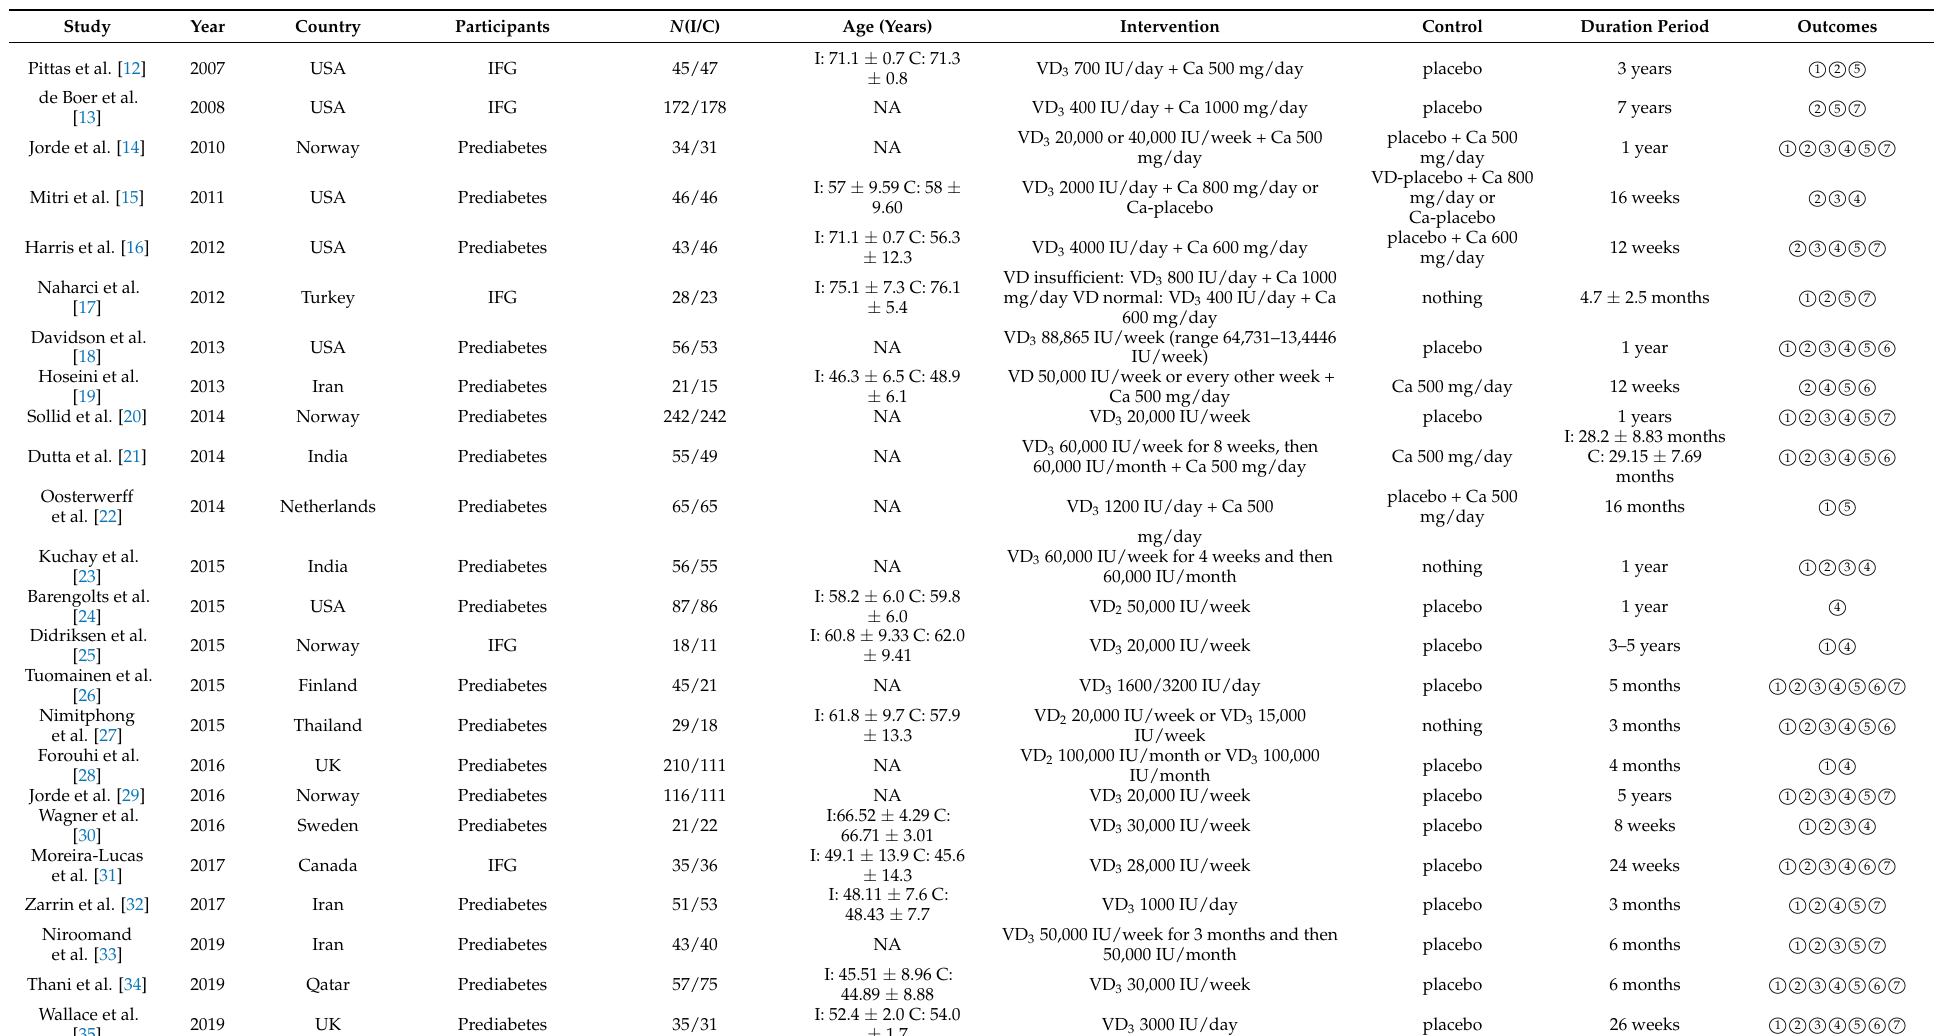
Table 1. Characteristics of studies included in the